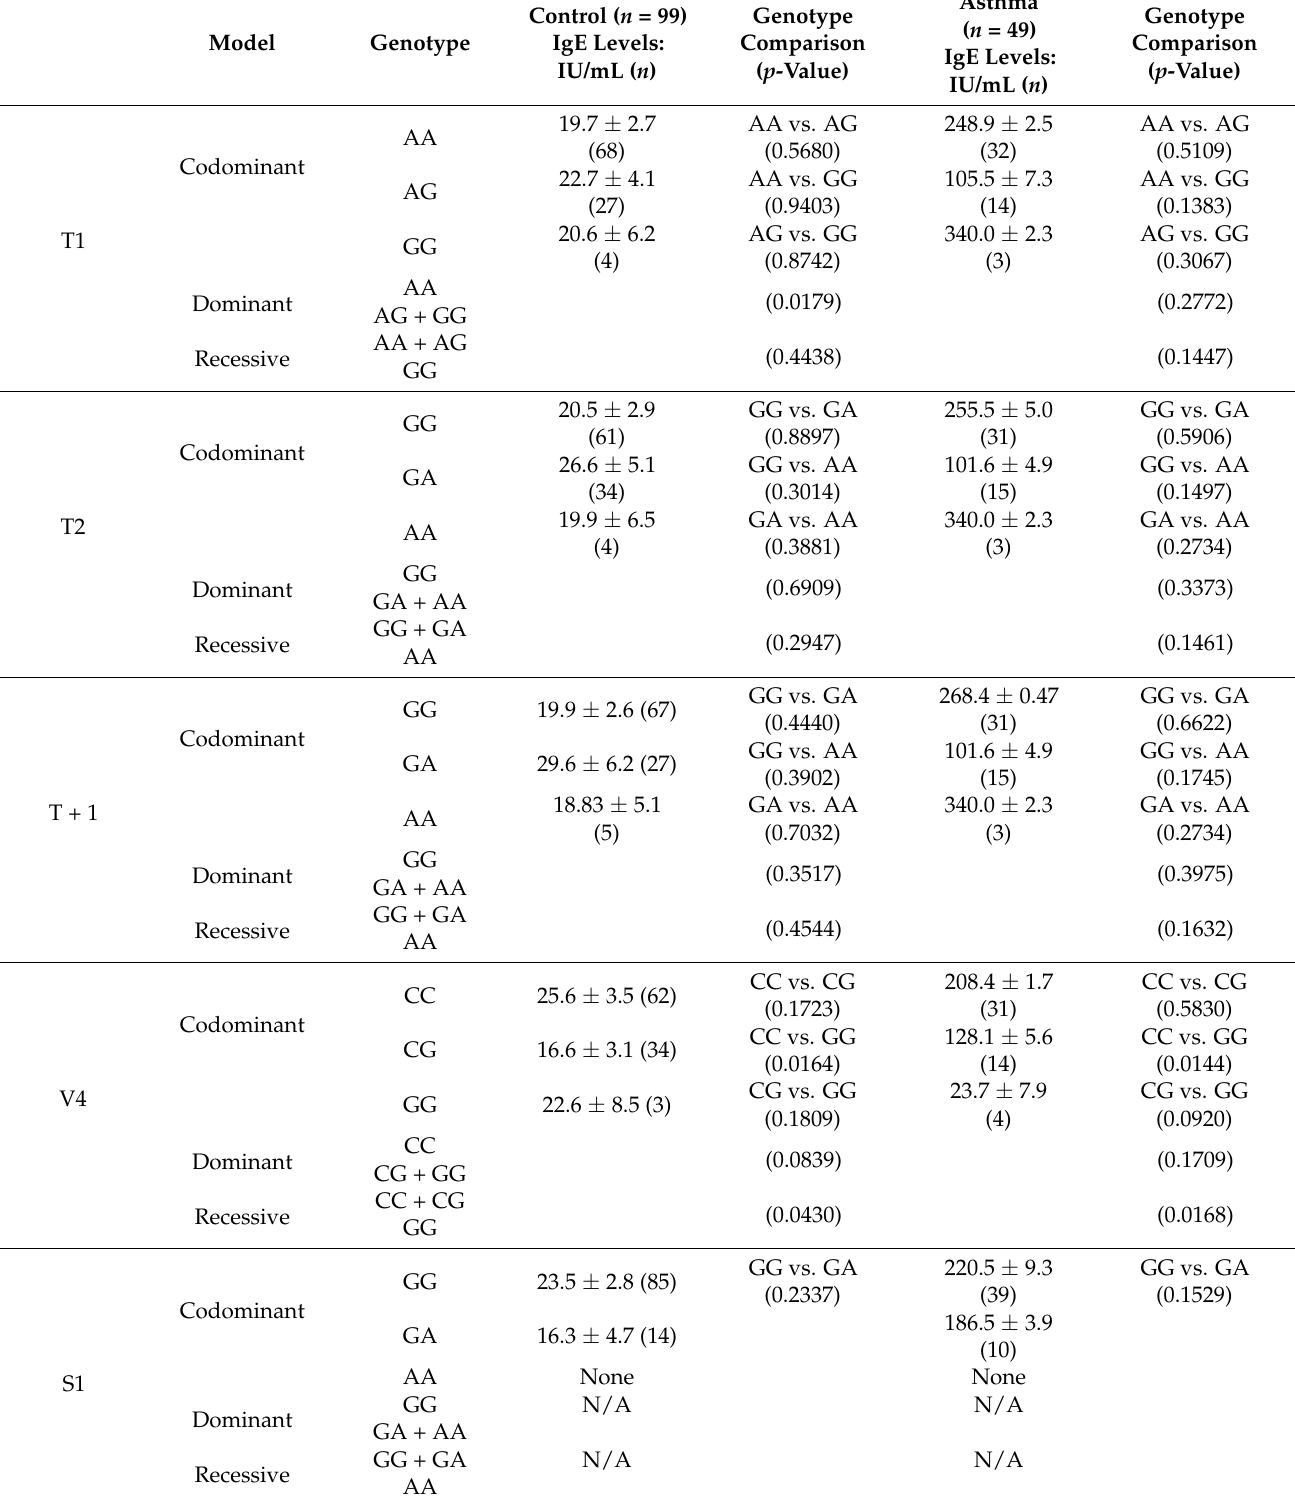
Table 6. Comparison between IgE levels of asthma patients and control group according to ADAM33 SNPs in